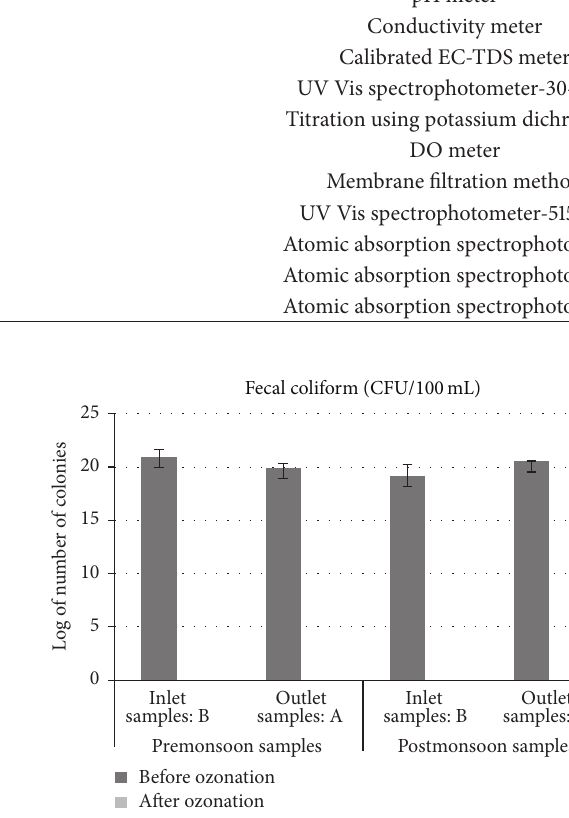
Figure 3: Fecal coliform of inlet and outlet samples before and after treatment by ozone. After ozonation, fecal coliform reduced to